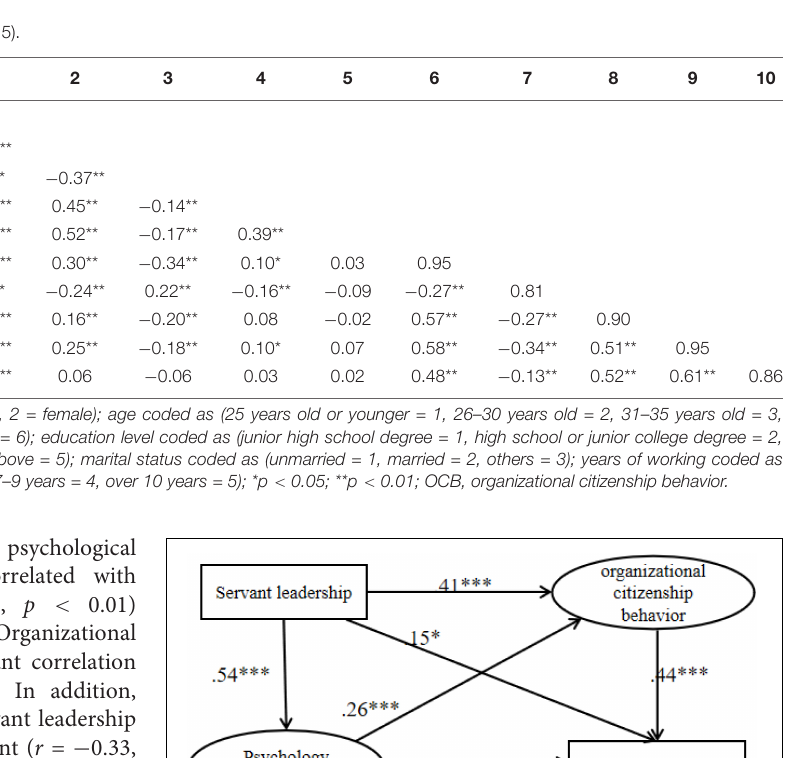
(organizational citizenship behavior and task